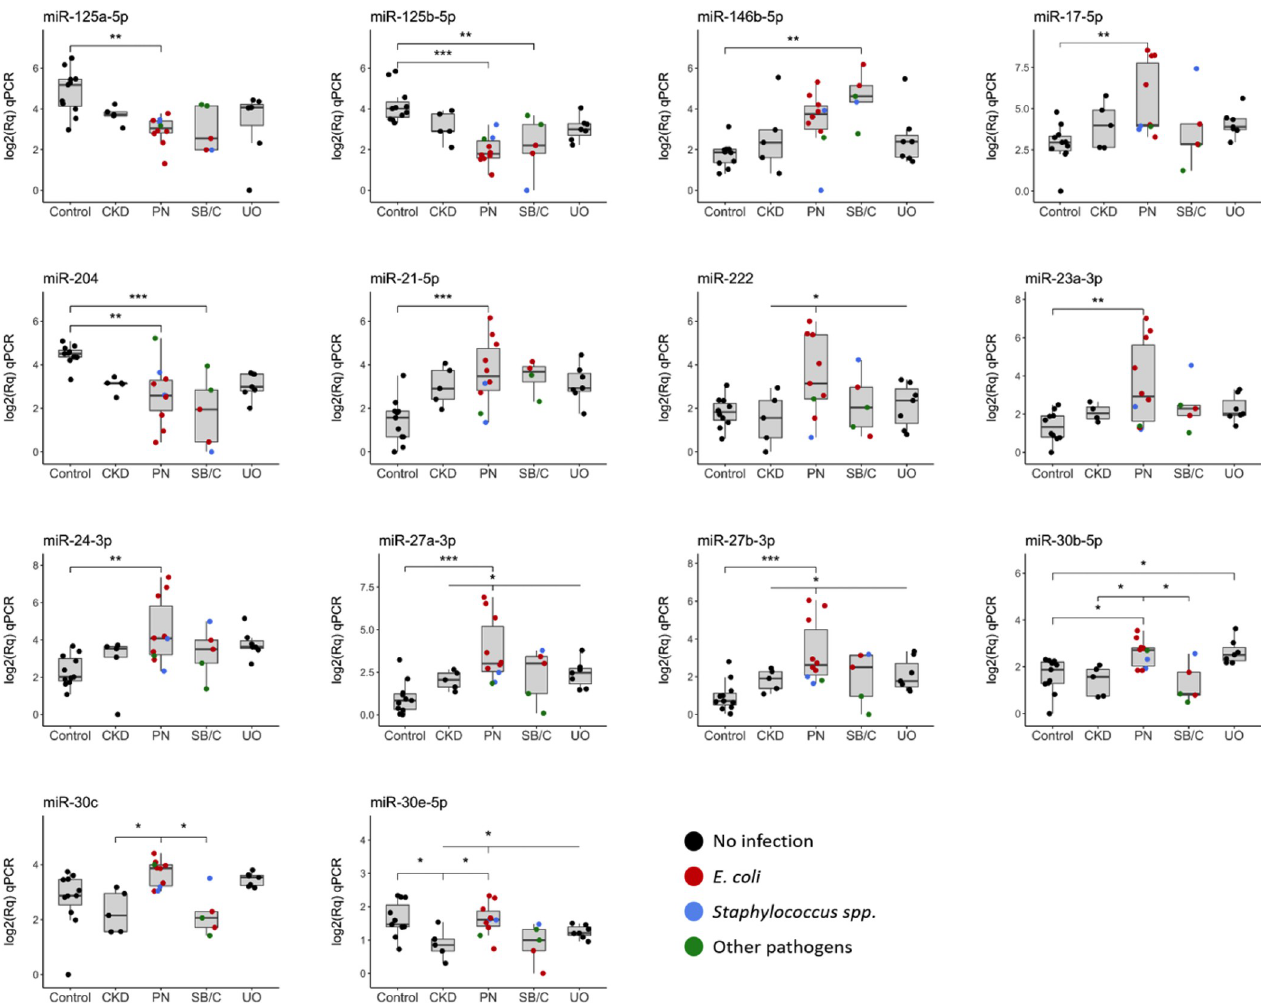
Fig 2. Box-plot of differentially abundant (DA) miRNAs between healthy Control cats and each of the defined groups by using qPCR. Selected miRNAs detected as DA (|log 2 FC| � 1.5; p -value < 0.05) are shown. Cats with culture-positive urine after cystocentesis are highlighted in red ( E . coli ), blue ( Staphylococcus spp .) and green (other pathogens), while cats with culture-negative urine are depicted in black. ��� : DA miRNAs with q -value < 0.01. �� : DA miRNAs with q -value > 0.01 & < 0.05. � : DA miRNAs with p -value < 0.05 but not significant after multiple testing correction ( q -value > 0.05). PN: Pyelonephritis, SB/C: Subclinical bacteriuria/Cystitis, UO: Ureteral obstruction, CKD: Chronic kidney